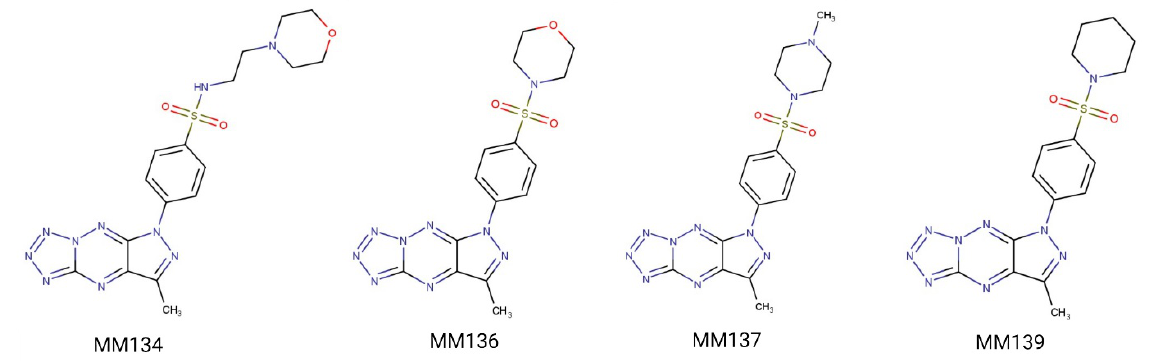
Figure 1. Investigated MM compounds: chemical structure of the four investigated sulfonamides MM134 , MM136 , MM137 , and MM139 .